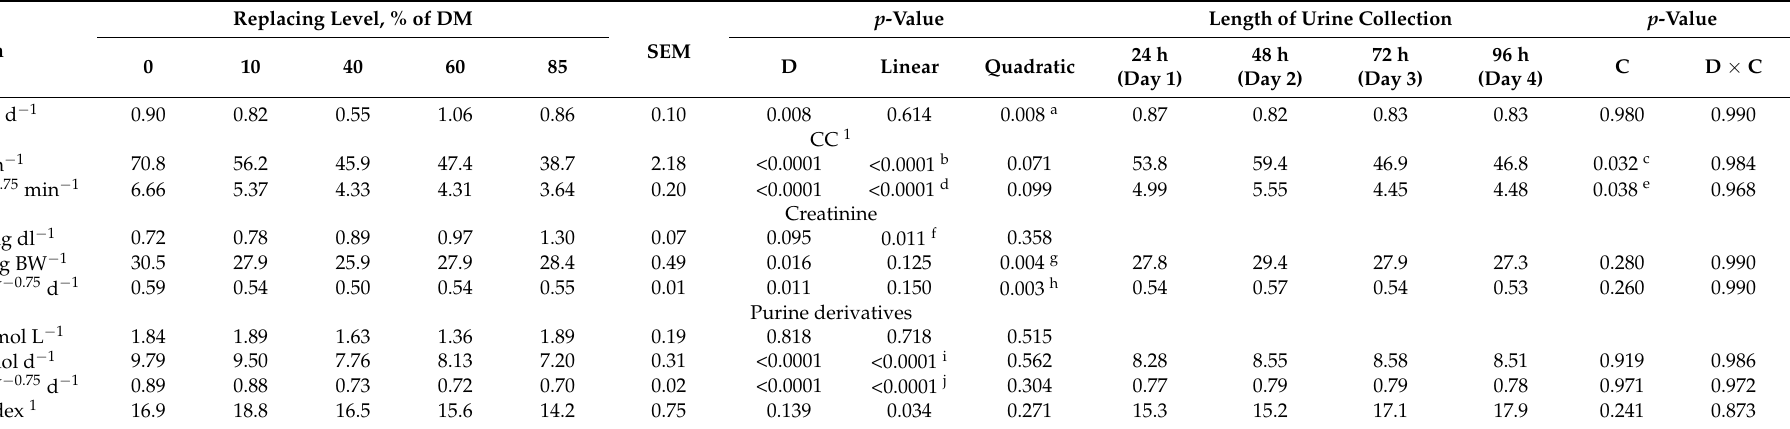
Table 3. Measured urine volume; endogenous creatinine clearance (CC); plasma and urinary creatinine; plasma and urinary purine derivatives (PD); PD/creatinine index using four days of 24-h total urine collections (C); and plasma concentration in lambs fed diets (D) containing peach palm replacing